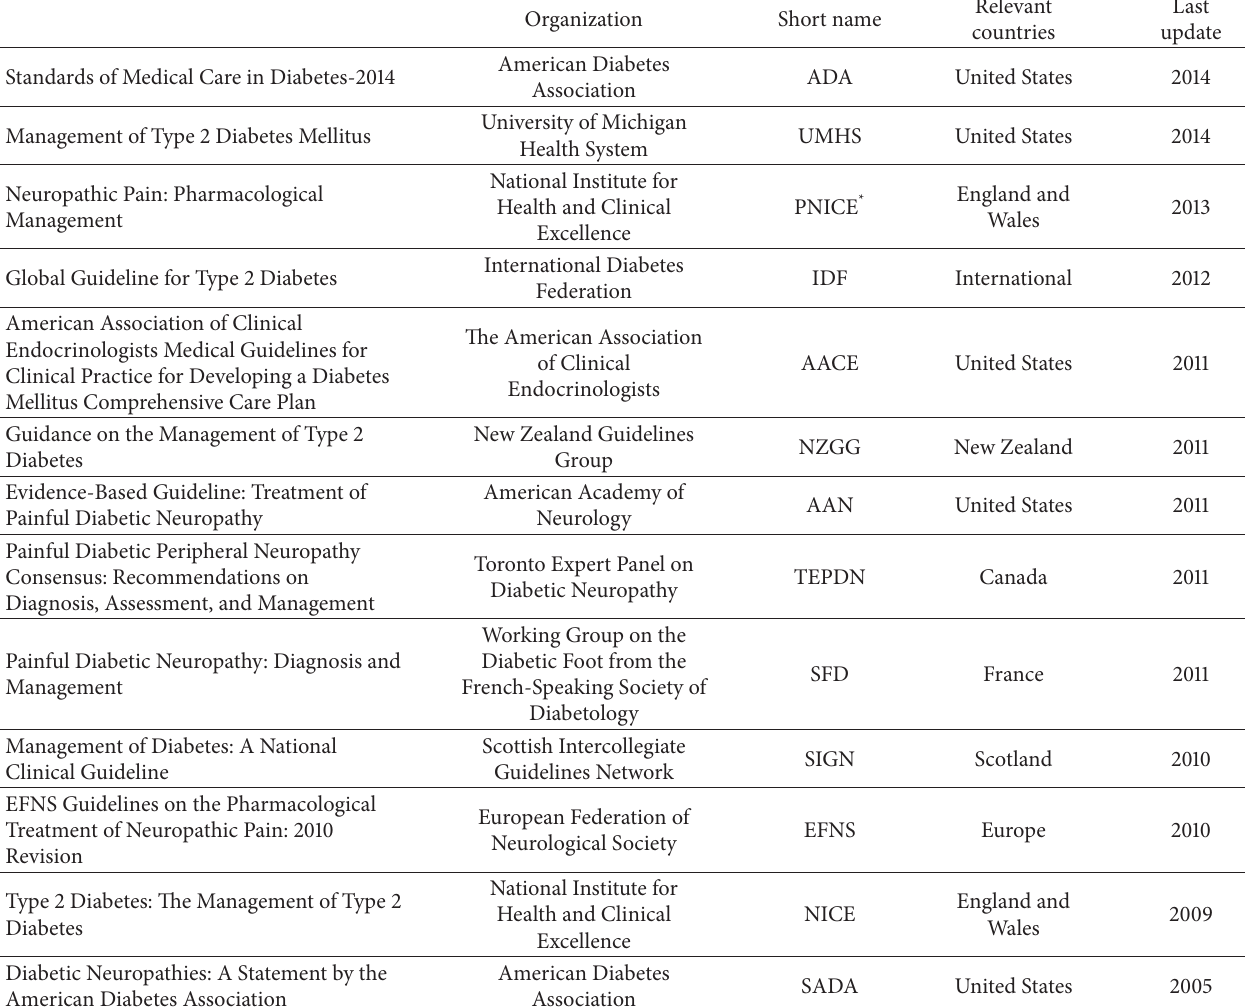
Table 1: Description of the guidelines included in this